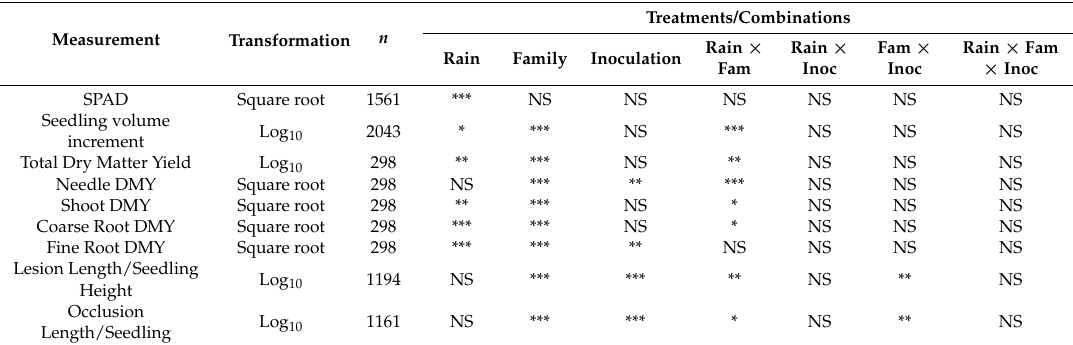
Table 2. Results of ANOVA F -tests.